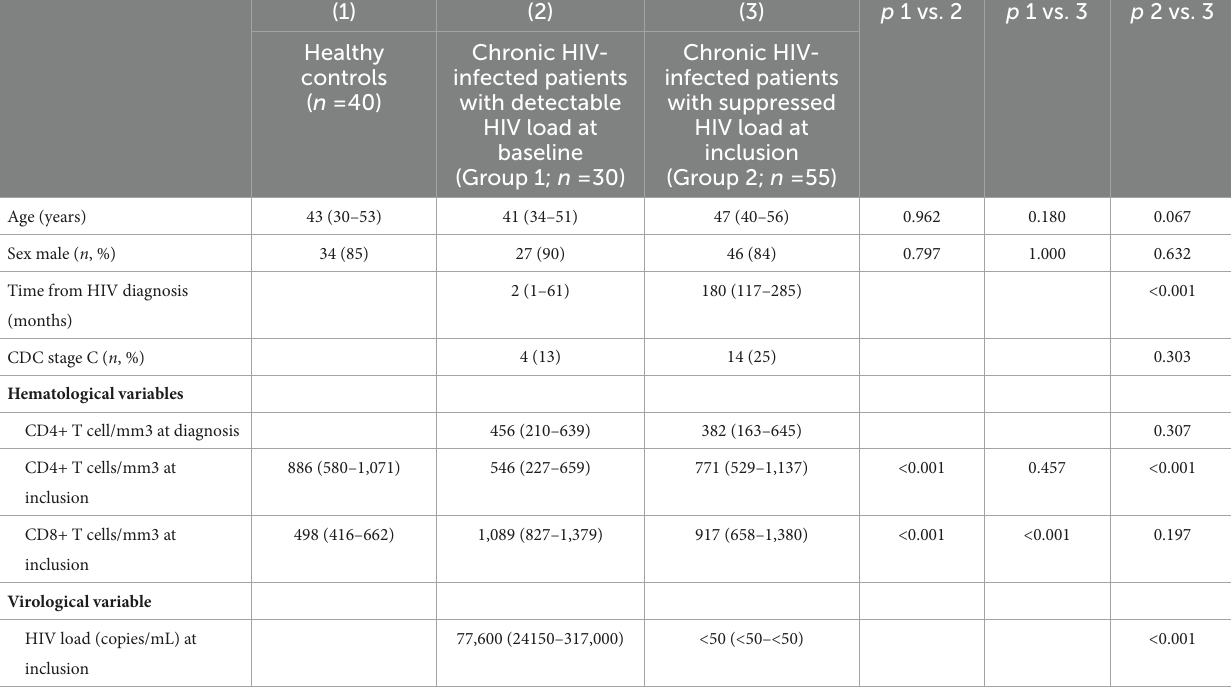
TABLE 1 Hematological, immune, and virological characteristics of healthy controls and HIV-infected